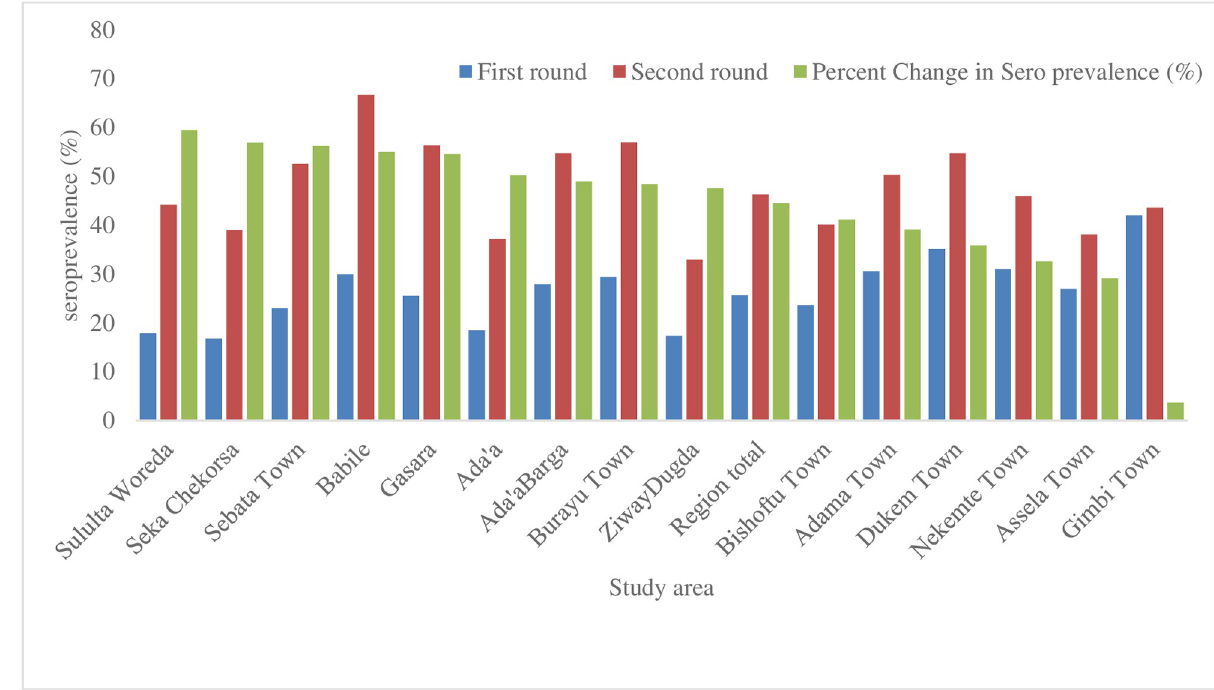
Fig 3. Seroprevalence of SARS-CoV-2 and percent change in seroprevalence after school reopening in hotspot districts in Oromia, Ethiopia during study period, first round (December 2020) to second round (April, 2021).